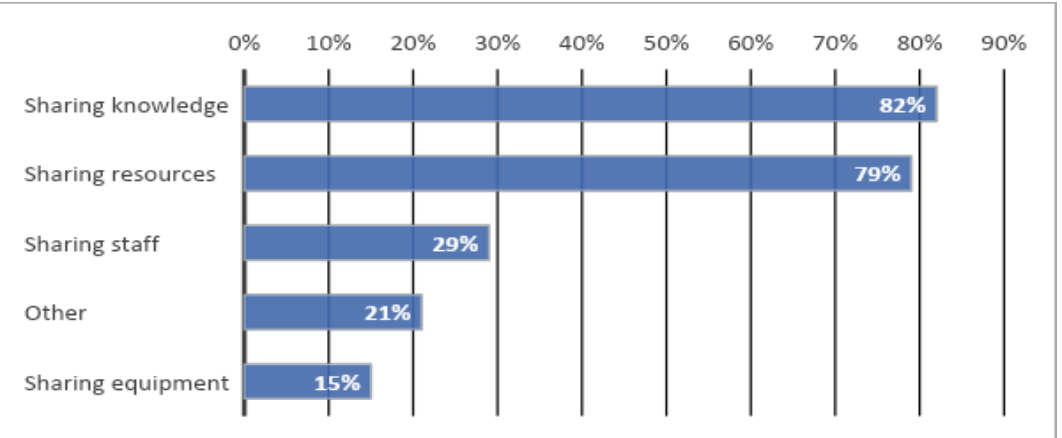
Figure 2. Partnership Approaches During the